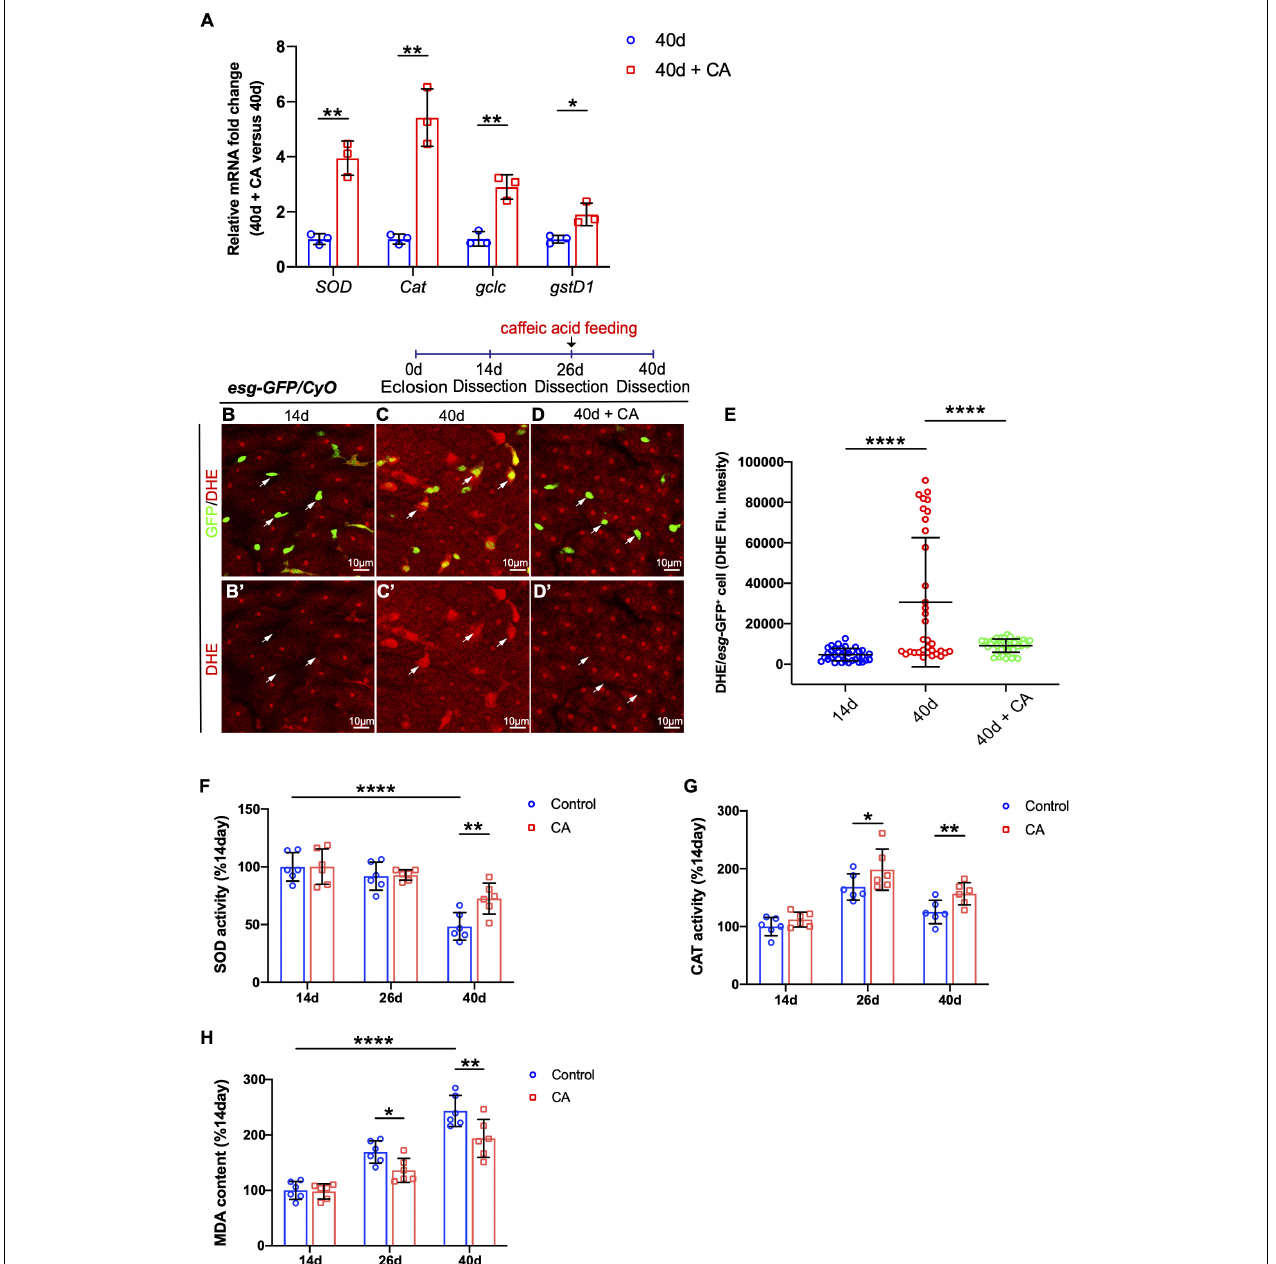
FIGURE 4 | Caffeic acid (CA) supplementation prevents ISC aging by promoting oxidation resistance. (A) Quantitative real-time PCR (RT–qPCR) detection of the mRNA expression of SOD , Cat , gclc , and gstD1 in the midguts of aged flies with or without CA supplementation. Error bars represent the SD of three independent experiments. (B–D) Representative immunofluorescence images of the R4 region of dissected midguts of 14-, 40-, and 40-day flies with CA supplementation. Arrows point to individual esg -positive cells. esg- GFP (green; ISC and EB markers) and DHE (red; an indicator of ROS). Panels (B–D) represent merged images and panels (B’–D’) are for DHE (red) only. (E) Quantification of DHE fluorescence in esg -positive cells of 14-, 40-, and 40-day flies with CA supplementation. Each dot represents one cell. (F) Quantification of the SOD activity (U/mg prot) of the midguts of flies fed with CA (marked with red columns) and without CA (marked with blue columns) at 14, 26, and 40 days. Error bars represent the SD of six independent experiments. (G) Quantification of the CAT activity (U/mg prot) of the midguts of flies fed with CA (marked with red columns) and without CA (marked with blue columns) at 14, 26, and 40 days. Error bars represent the SD of six independent experiments. (H) Quantification of the MDA content (nmol/mg prot) of the midguts of flies fed with CA (marked with red columns) and without CA (marked with blue columns) at 14, 26, and 40 days. Error bars represent the SD of six independent experiments. Scale bars represent 10 µ m in panels (B–D) . Error bars represent SDs. One-way and two-way ANOVA test, * P < 0.05, ** P < 0.01, **** P < 0.0001, and non-significant (NS) represents P > 0.05.